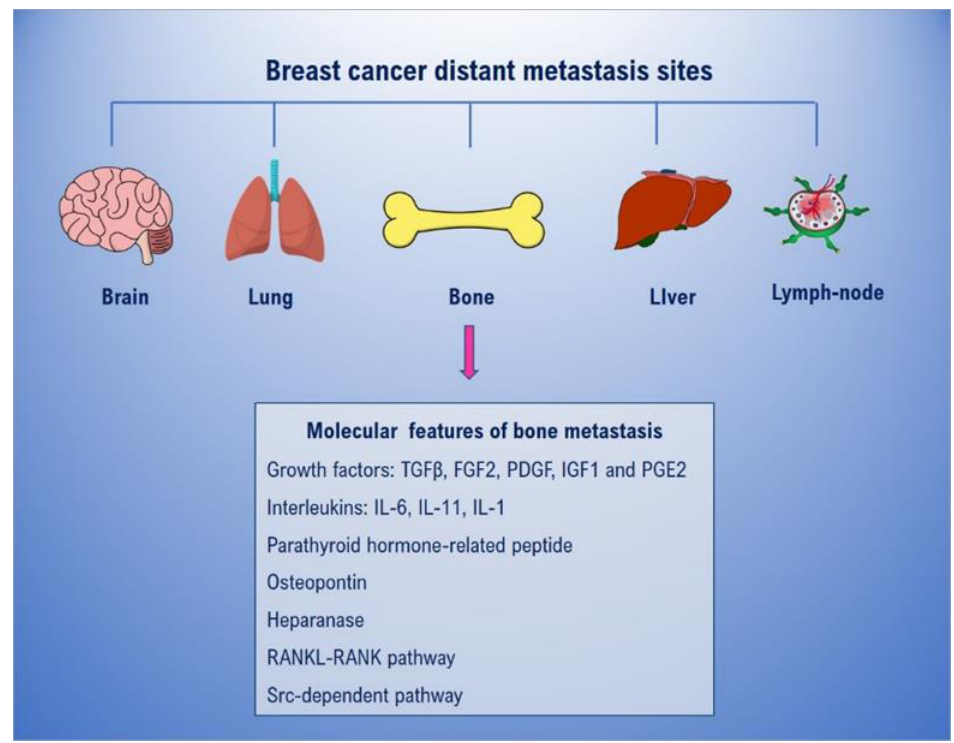
Figure 1. Breast cancer distant metastasis sites and molecular features of bone metastasis.